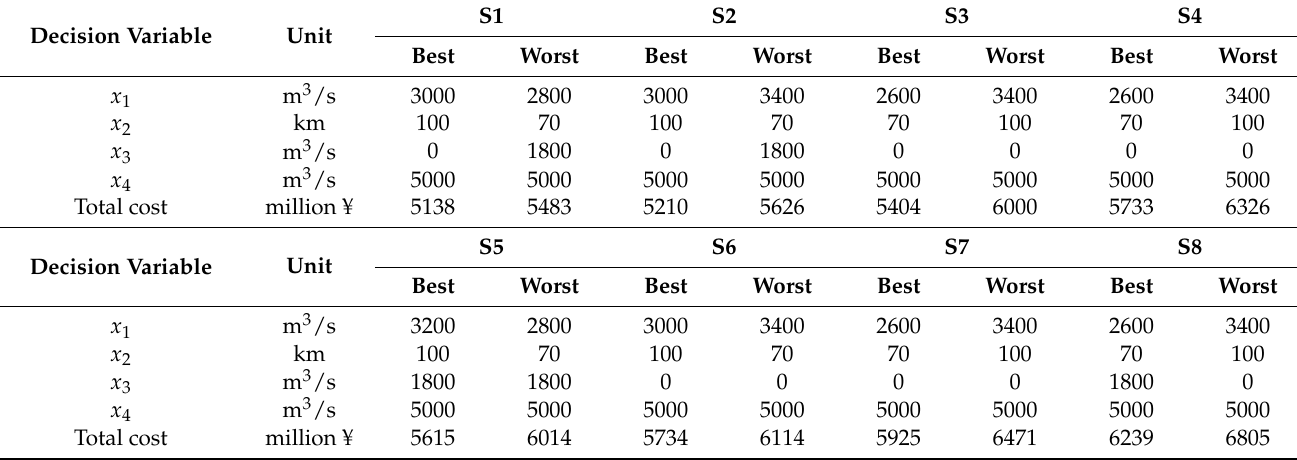
Table 4. Summary of the best and worst decisions and total cost under each scenario ( x 1 = threshold triggering engineered avulsion decisions; x 2 = location of engineered avulsion; x 3 = floodway; x 4 = river flow triggering the use of